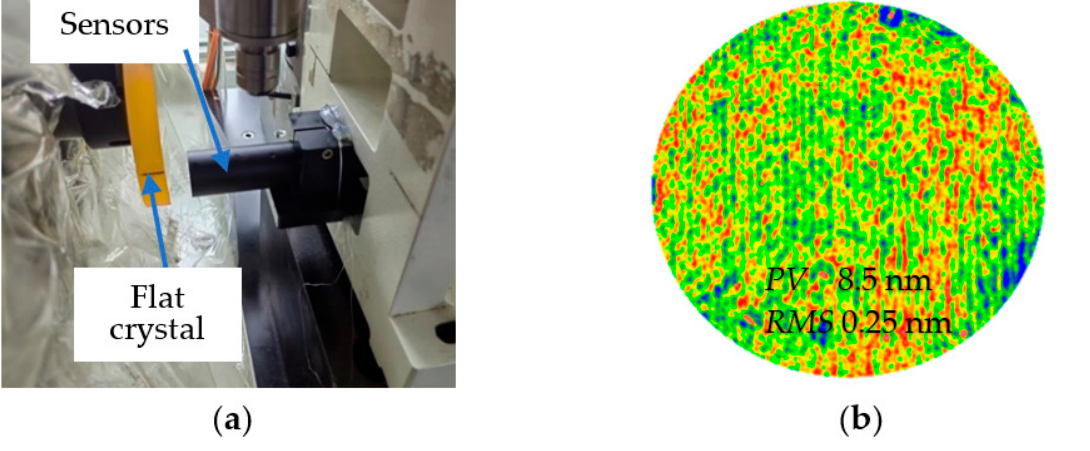
Figure 3. Periodic vibration measurement. ( a ) Mode of measurement. ( b ) Accuracy of flat crystal shape.